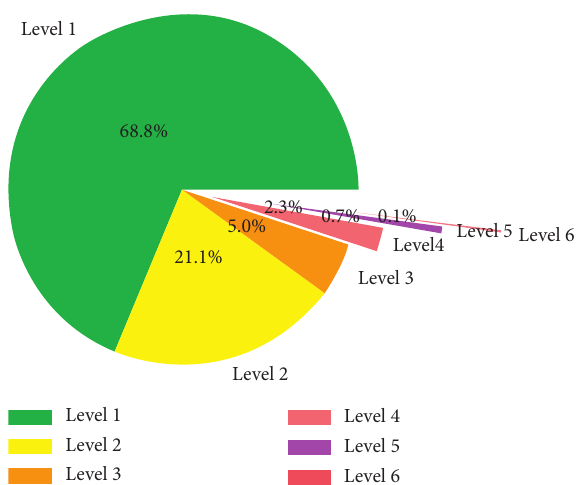
Figure 6: Proportion of pollution level